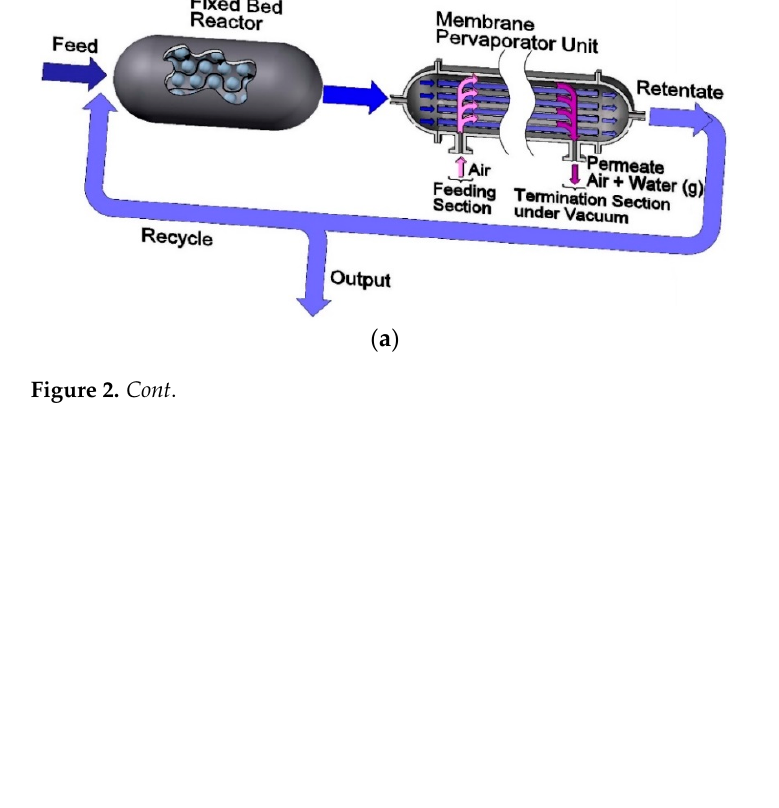
Table 2. Permeation model parameters of a hydrophilic silica membrane for the pervaporation of an acetic acid, isoamyl alcohol, isoamyl acetate, and water mixture.